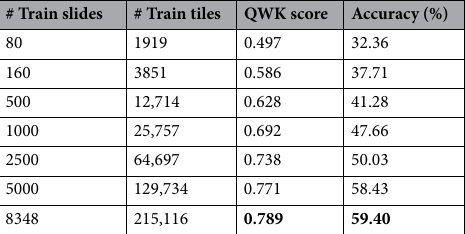
Table 5. Evolution of the model performance when trained on subsets of the PCa dataset with different sizes, keeping the test set size constant (n=1,477). Bold values indicate best results